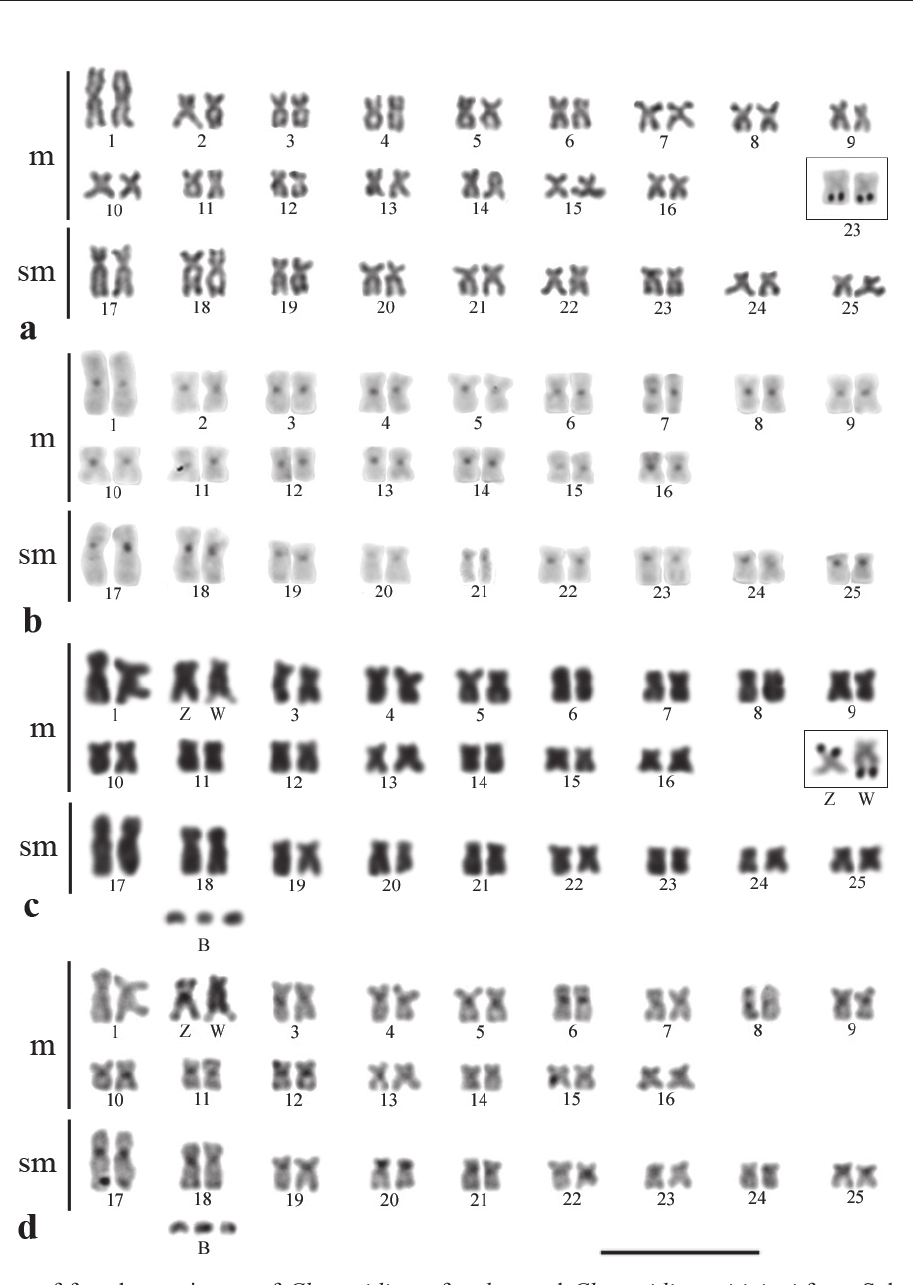
Fig. 2. Karyotypes of female specimens of Characidium cf. zebra and Characidium oiticicai from Salesópolis, SP, after conventional Giemsa staining (a, c) and C-banding (b, d), respectively. Note the differential patterns of heterochromatic blocks on the chromosomes and the differentiated sex chromosomes and heterochromatic B-chromosomes in Characidium oiticicai . In the box, the NOR-bearing chromosomes. Scale bar = 10